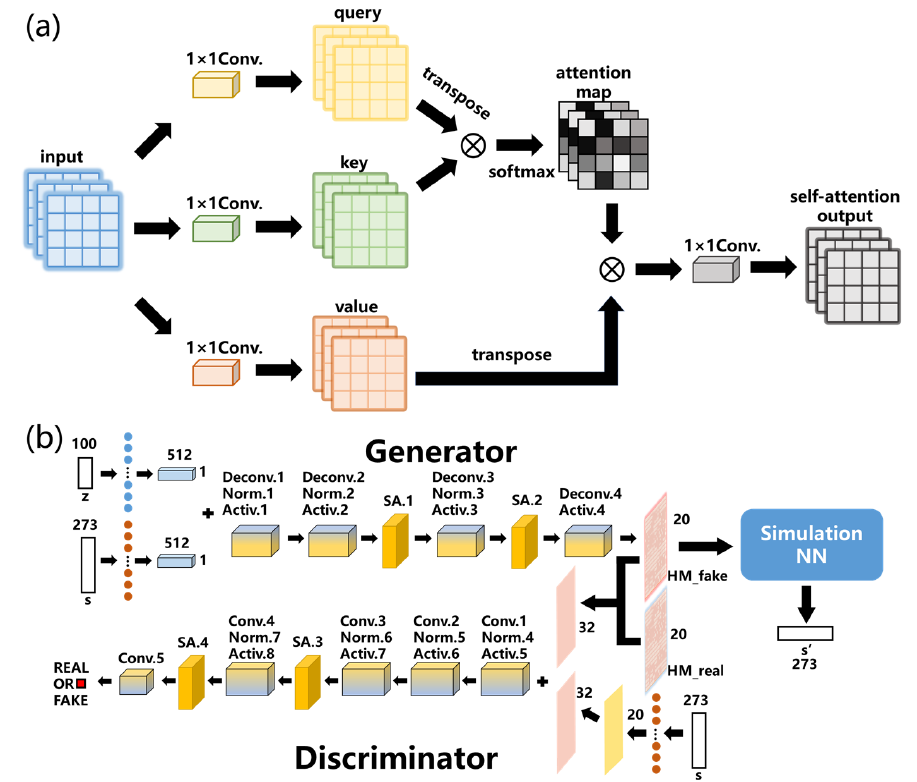
Figure 8. The self-attention mechanism used in SAGAN. ( a ) The schematic diagram of the self- attention layer, where  represents the matrix multiplication, and ( b ) the framework of SAGAN- sim model.